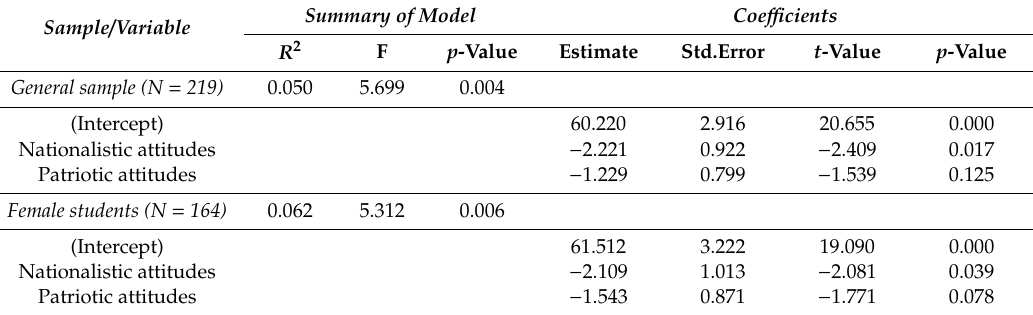
Table 5. Best predictor regression models for Minimization subscale of